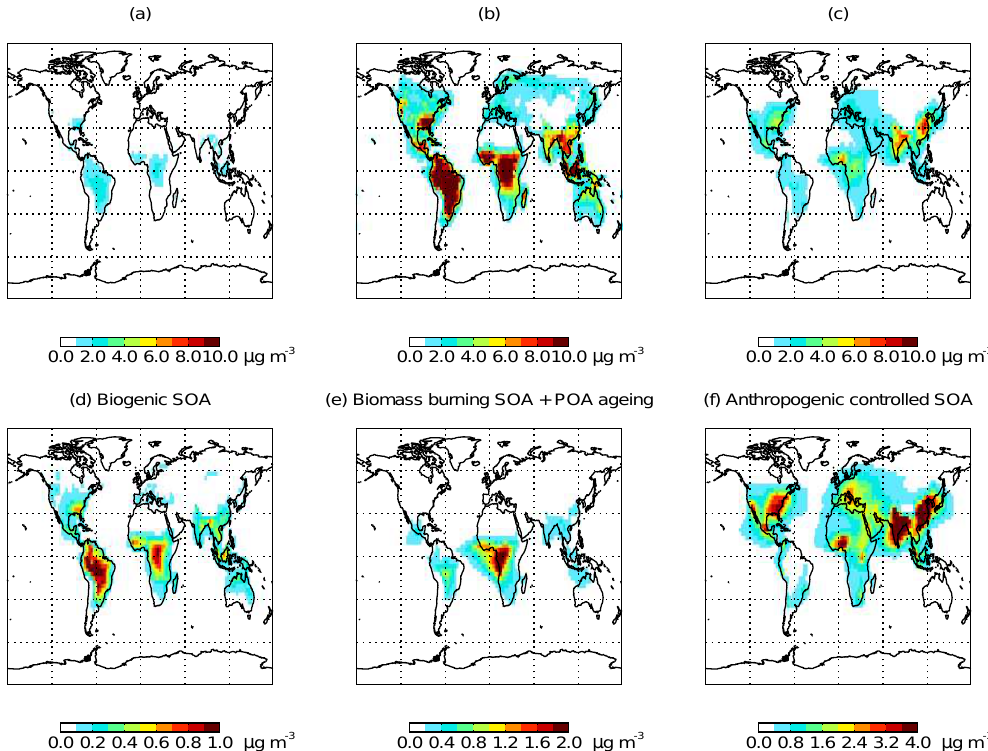
Fig. 7. Surface annual mean concentrations of SOA simulated in (a) standard model (simulation 1), (b) with enhanced biogenic SOA (simulation 3) and (c) with best estimate SOA sources (simulation 33). For our best estimate sources the contribution from (d) biogenic SOA only, (e) biomass SOA and POA ageing, and (e) anthropogenic pollution controlled SOA are shown. The colour scales saturate.